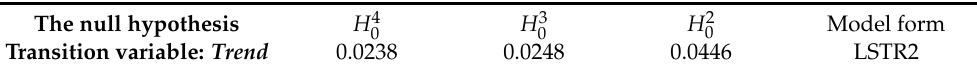
Table 6. Results of smooth transition regressionmodel form.